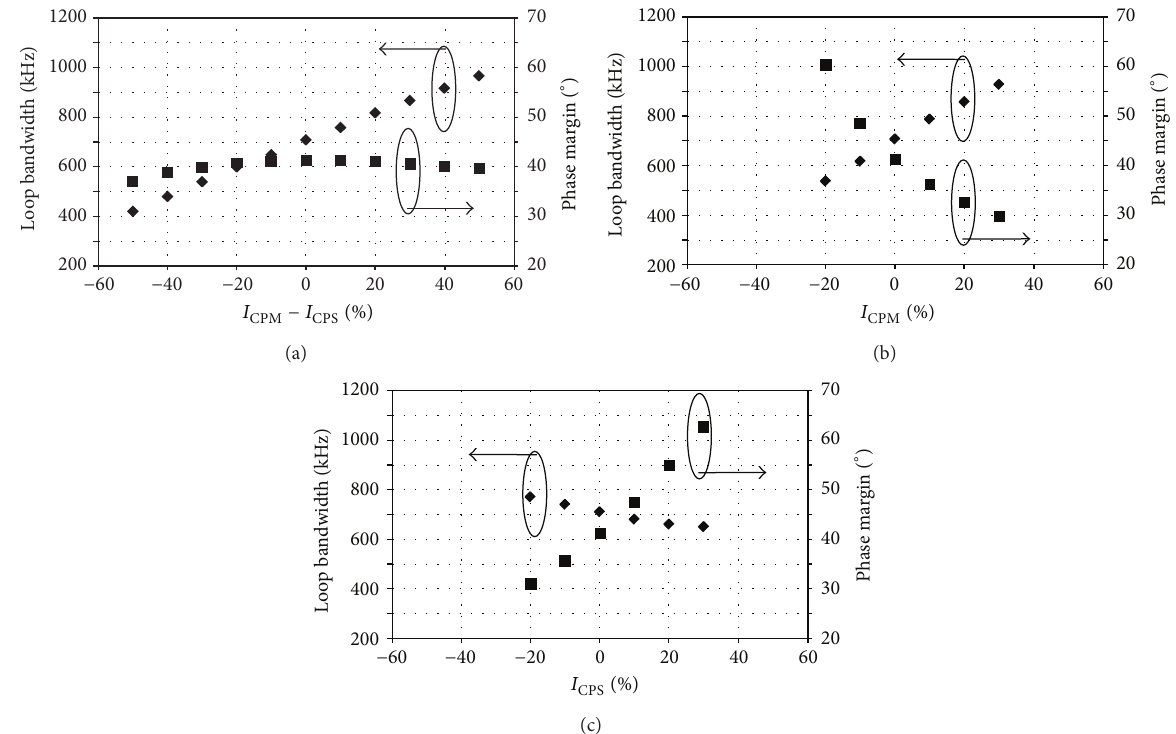
− 𝐼 ). (b) The CPM CPS